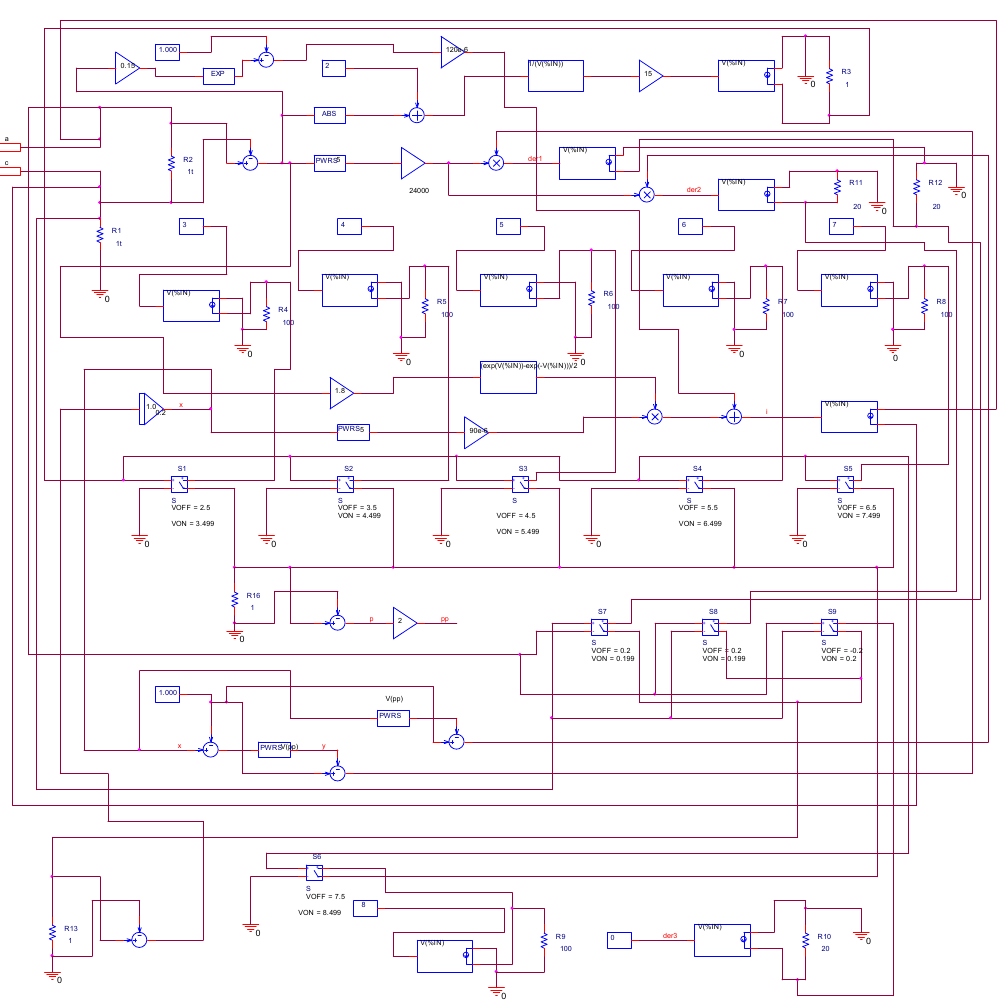
Figure 2. A PSpice schematic of Lehtonen-Laiho model with a modified Biolek window function [25].